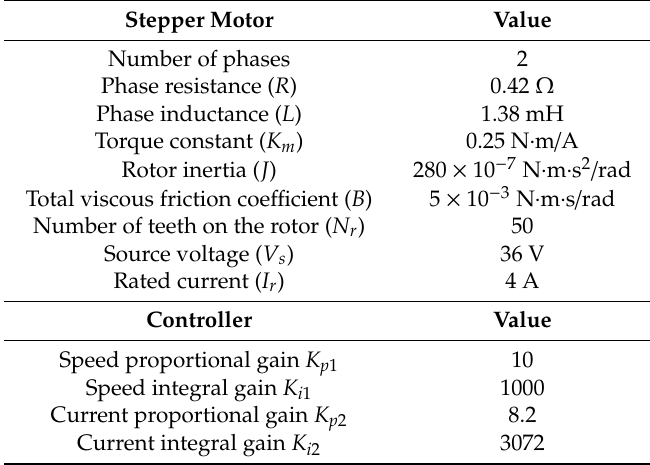
Figure 10. Photograph of the experimental setup. Table 2. Parameters of a two-phase hybrid stepper motor and the controller.